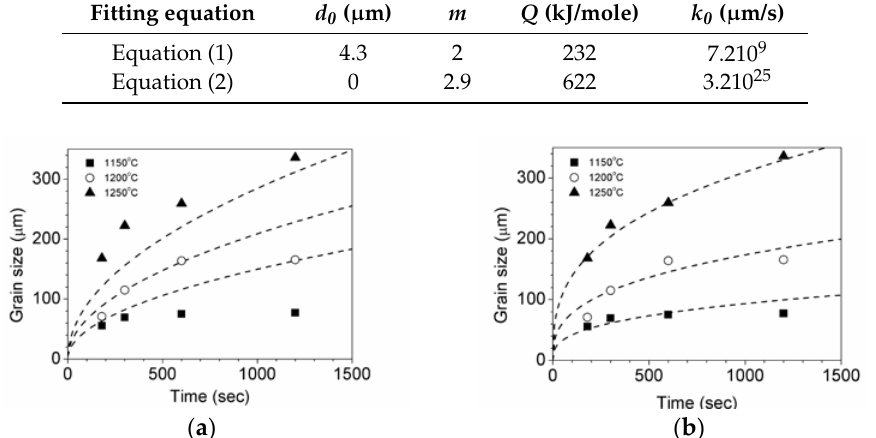
Figure 5. Mean value of grain size as a function of time using ( a ) Equation (1) with an R-value of 0.96 and ( b ) Equation (2) with an R-value of 0.69 for SS400 with 1.5 ppm Mg.